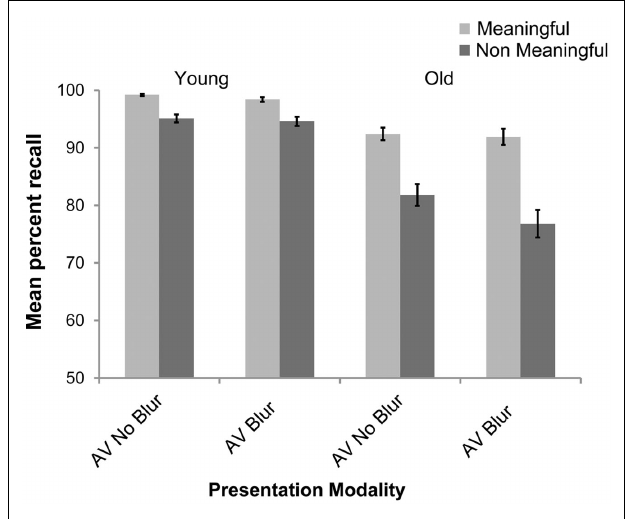
FIGURE 3 | Mean percent correct for sentence recall as a function of sentence type (meaningful/non-meaningful) and presentation modality (audio – visual blur/audio – visual no blur) for both younger and older adult groups.